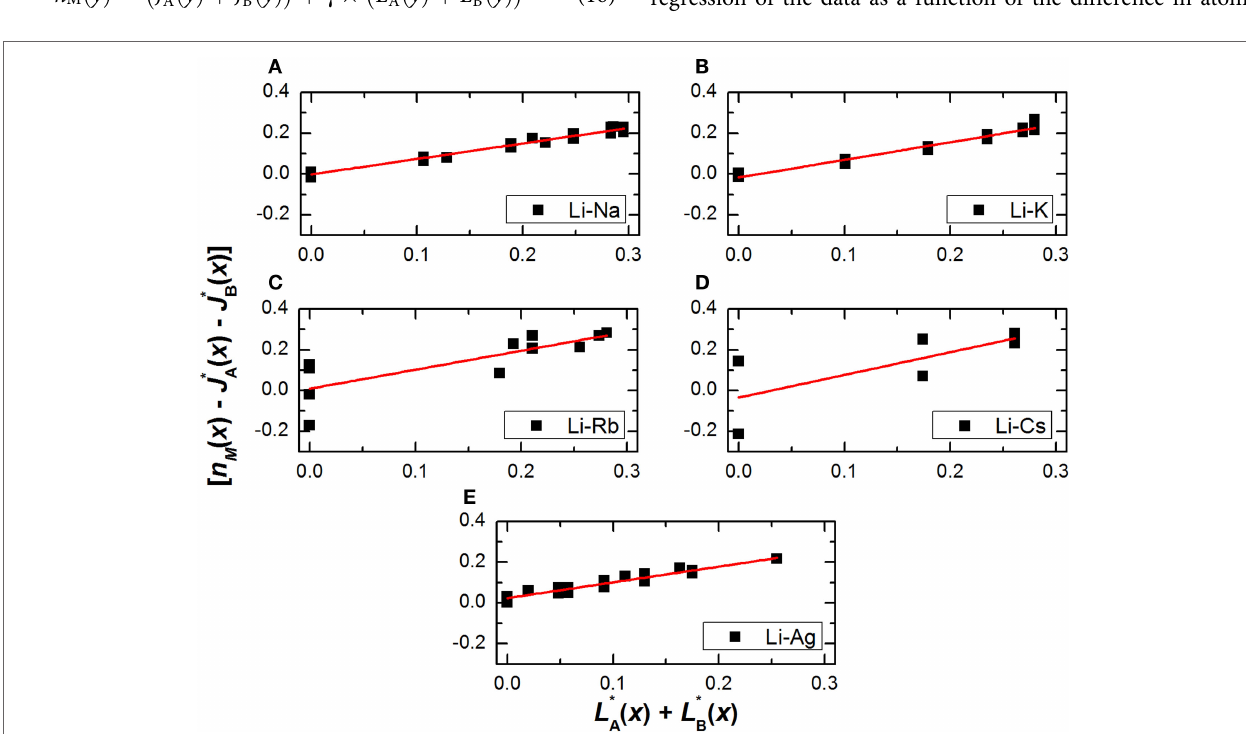
FIGURE 1 | Plots of [ n M ( x ) (cid:0) J (cid:3) A ( x ) (cid:0) J (cid:3) B ( x )] (cid:2) L (cid:3) A ( x ) + L (cid:3) B ( x ) for mixed Li–Na (A), Li–K (B), Li–Rb (C), Li–Cs (D), and Li–Ag (E), metaphosphate glasses . The straight line shows the linear regression of the plotted data.